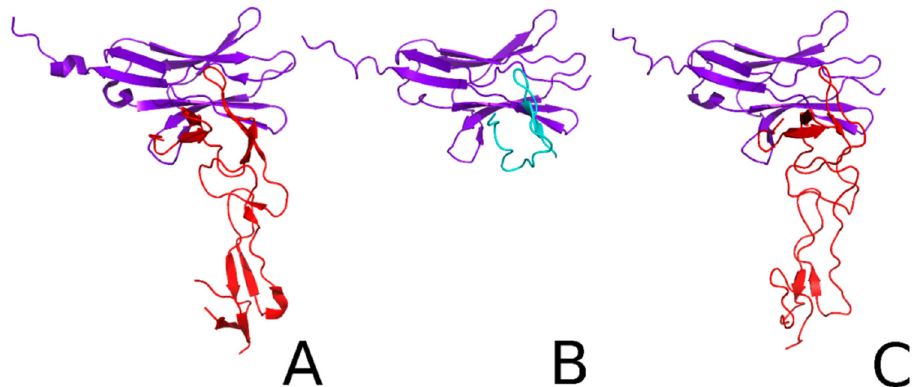
Figure 8. ( A ) Crystal structure of the Herpes Virus Entry Mediator (HVEM) peptide complex B- and T-lymphocyte Attenuator (BTLA) (PDB code: 2AW2), in which the purple color indicates BTLA and red indicates HVEM; ( B ) The dominant cluster of the HVEM(14–39) peptide–BTLA complex obtained from UNRES simulation, in which the purple color indicates BTLA and cyan blue indicates the peptide; ( C ) The fourth cluster of the BTLA–HVEM complex obtained from UNRES simulation, in which HVEM and BTLA are highlighted in red and purple, respectively. Reproduced with permission from M. Spodzieja et al., Int. J. Mol. Sci. , 21, 636 (2020) under Creative Common CC BY